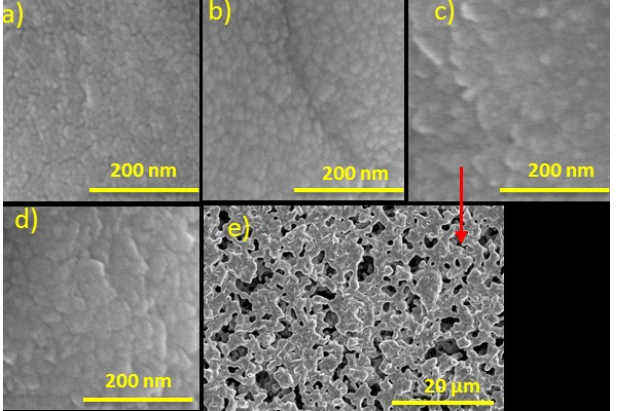
Figure 2. Measured sensor potential versus pH for different Ar/O 2 gas ratios.